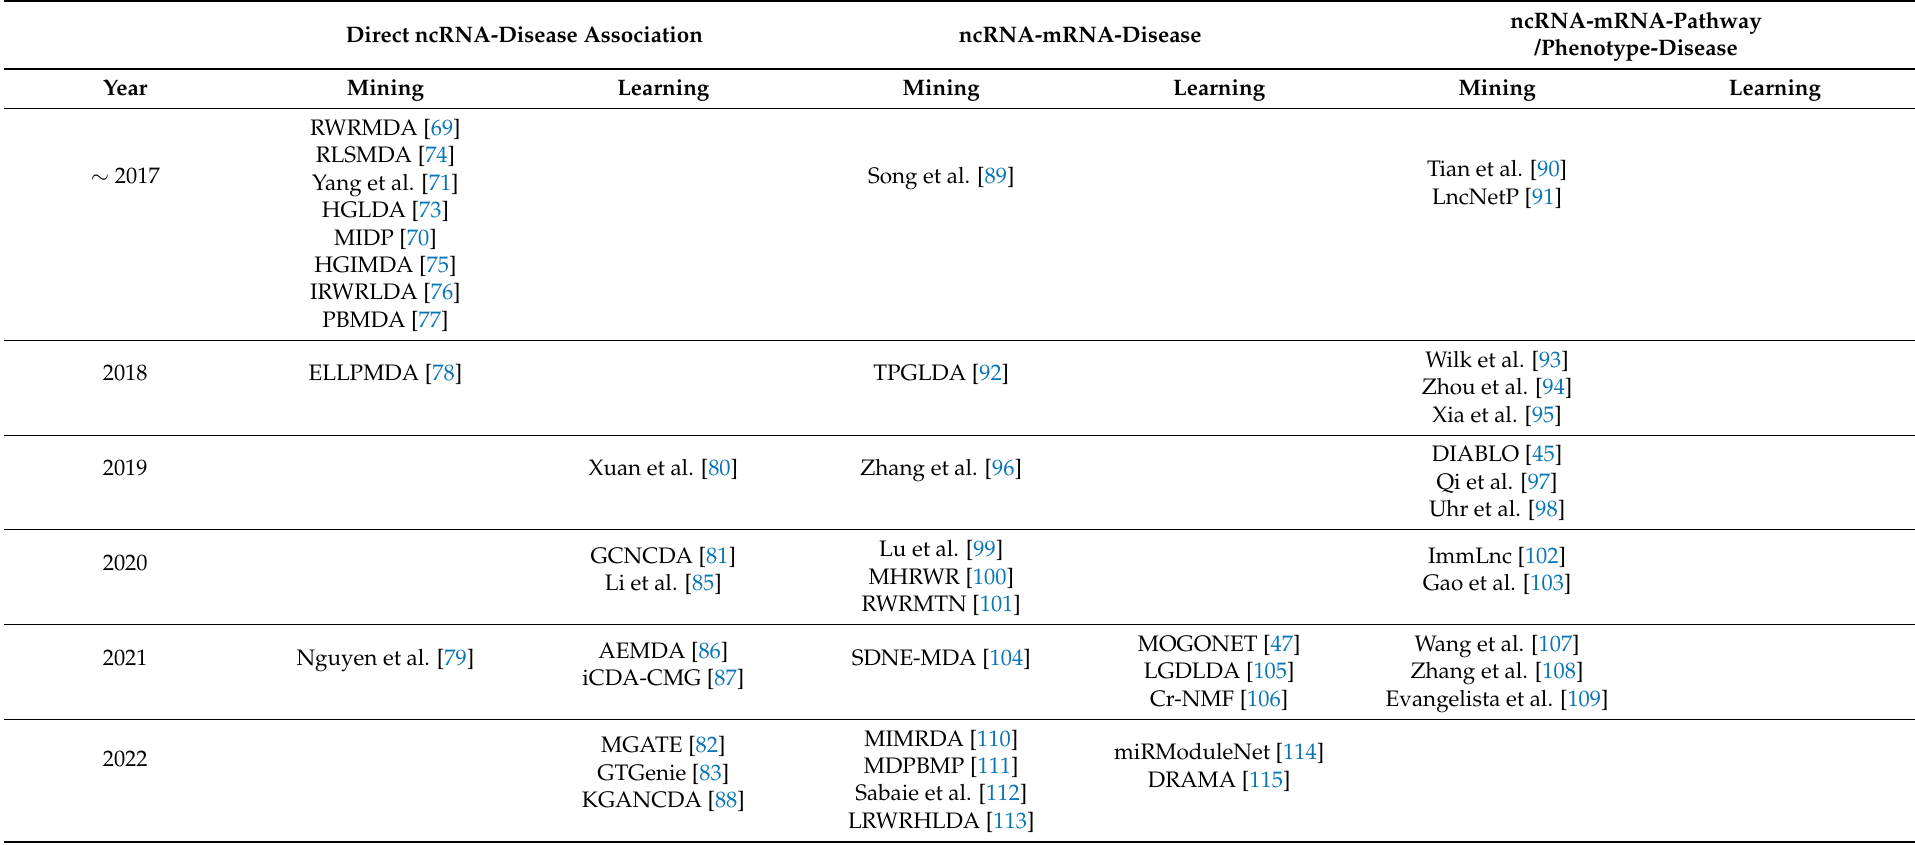
Table 2. Summary of computational ncRNA-disease association